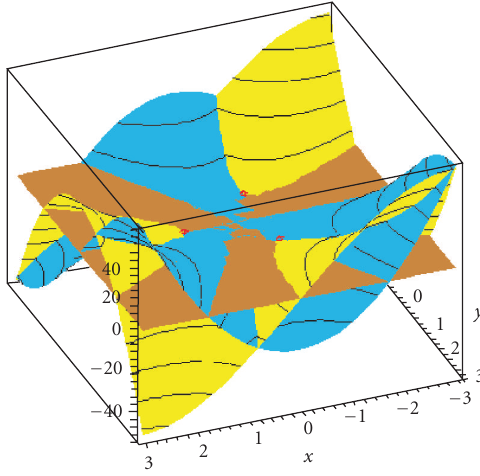
Figure 5.7. Solutions of the cubic